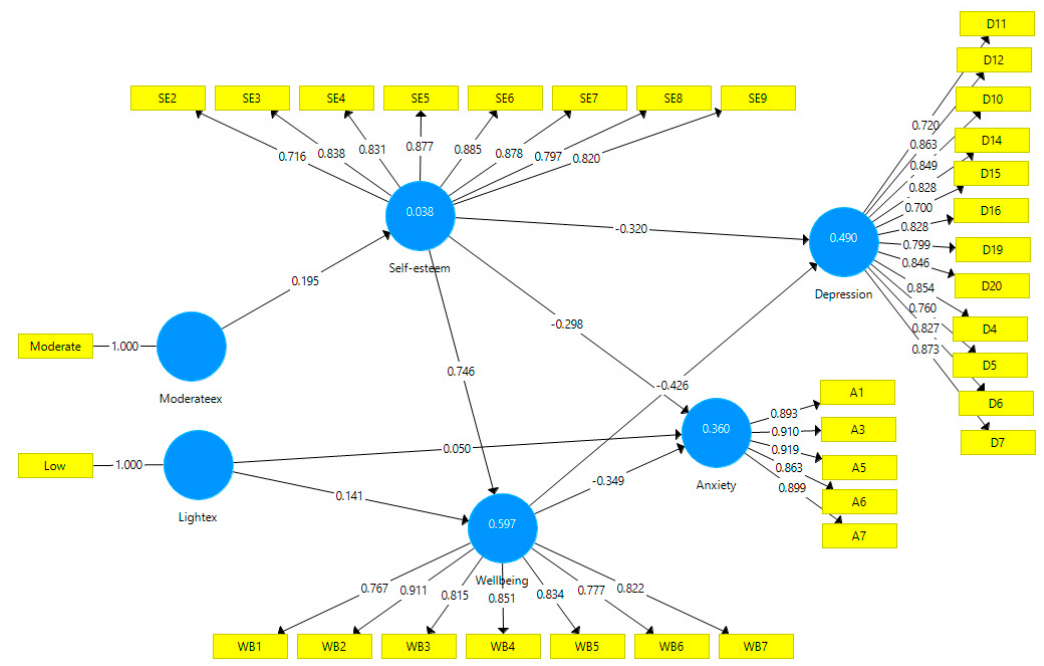
Figure 3. PLS structural model (source: authors).